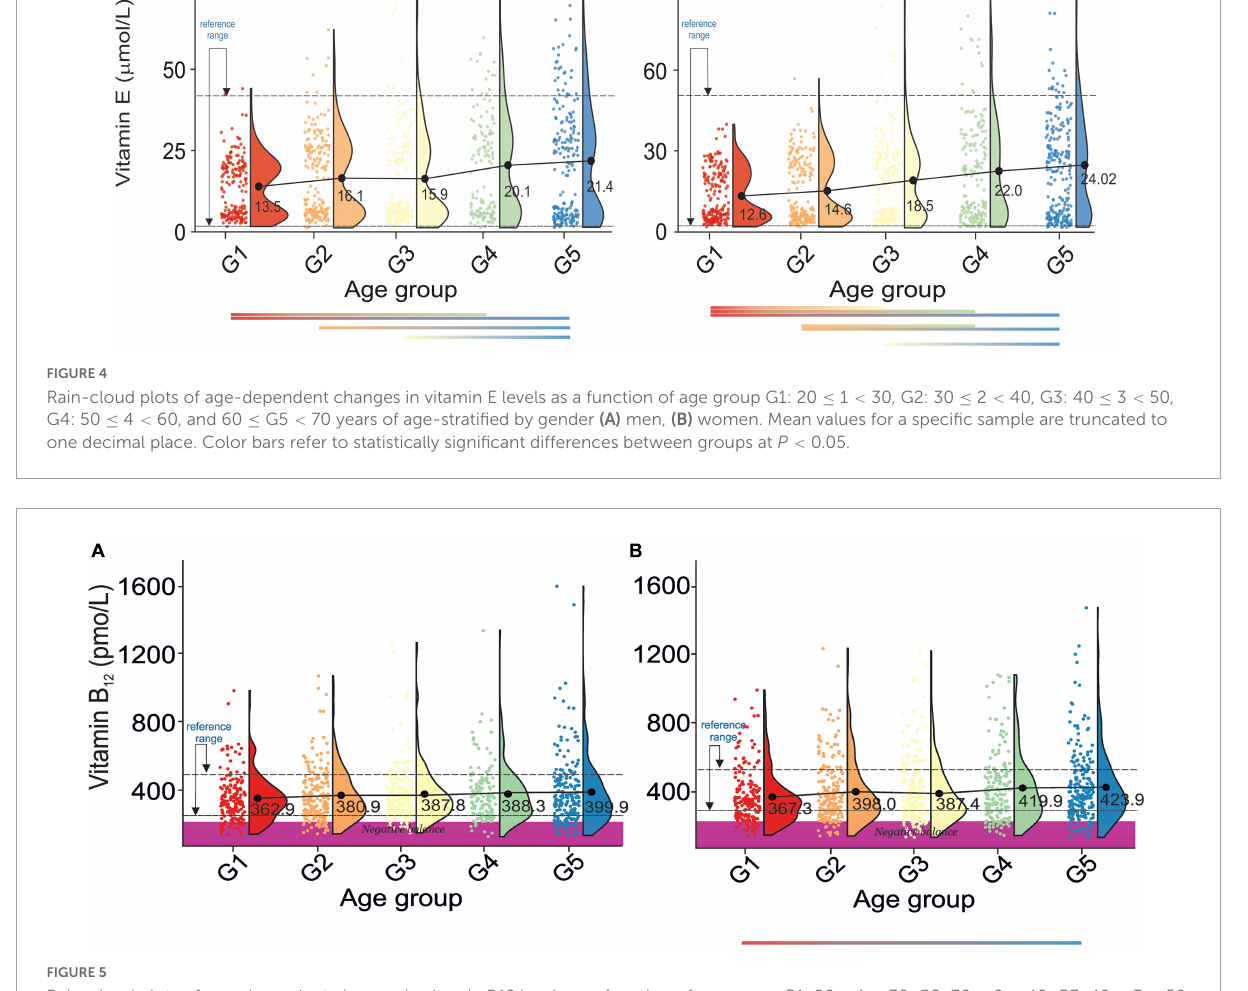
in males with serum/plasma vitamin A concentrations greater than 1.40